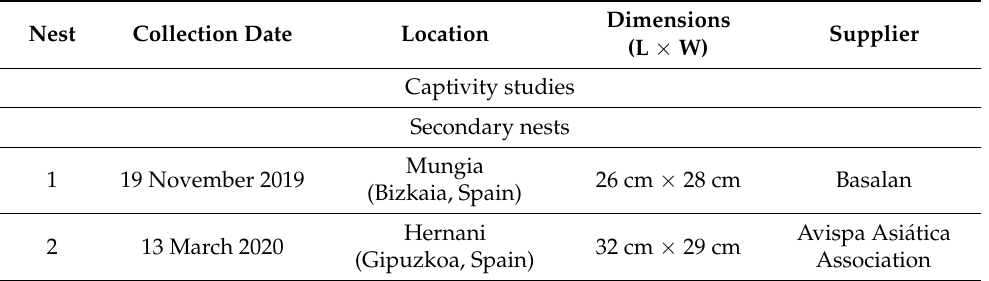
Table 1. Collection dates, locations, nest dimensions (total length, L, and width, W), and suppliers of the different nests of Vespa velutina for captivity and larvae